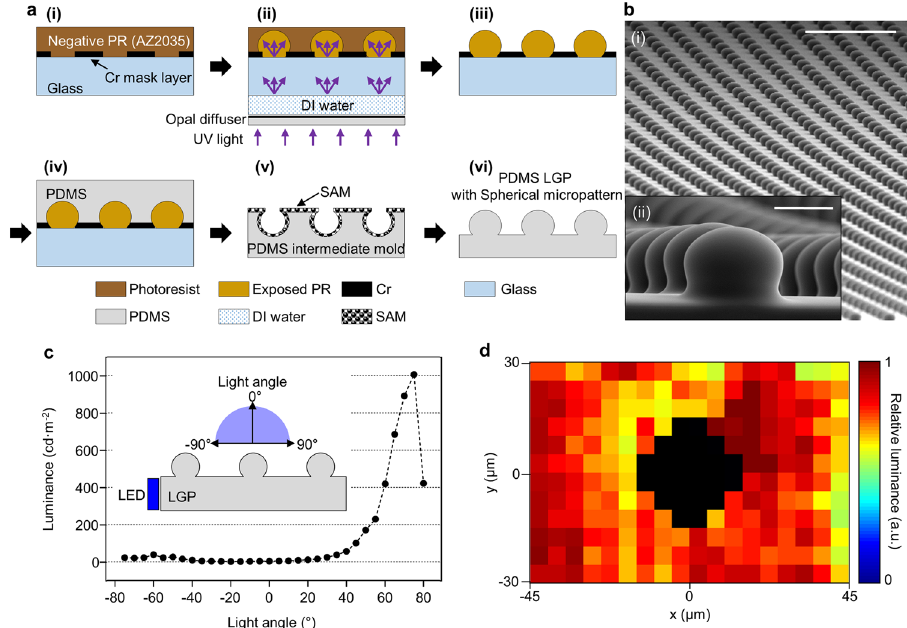
Fig. 3 Fabrication and characterization of the PDMS LGP with spherical light out-coupler. a The fabrication process for the proposed PDMS LGP: (i) negative photoresist coating on the patterned Cr layer, (ii) backside diffuser lithography, (iii) photoresist mold after development, (iv) liquid PDMS coating and curing, (v) replication of the intermediate mold and self-assembled monolayer coating, and (vi) PDMS LGP replication. b Scanning electron microscopy image of the fabricated PDMS LGP. c Measured angular luminance distributions of the fabricated PDMS LGP. d luminance distribution around the light out-coupler based on the measured result using 10- μ m fl uorescent beads. Scale bar: 100 μ m ( b -i) 10 μ m ( b